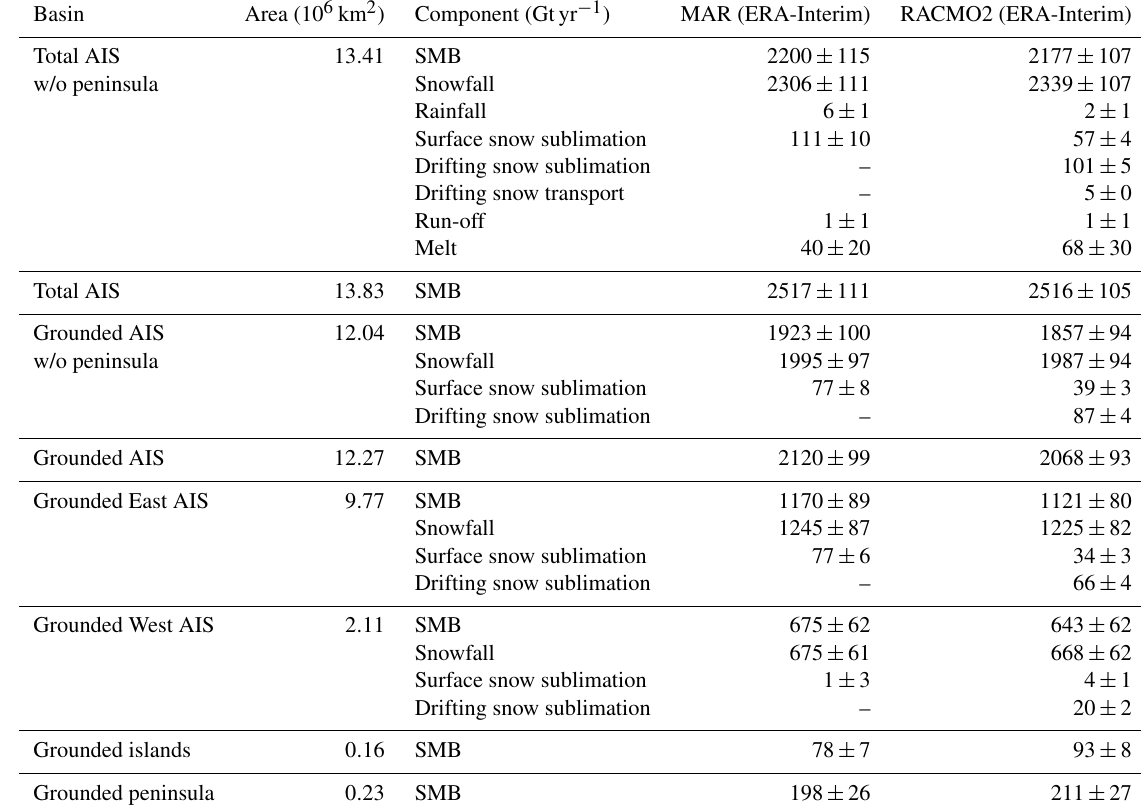
Table 2. Antarctic integrated SMB on average for 1979–2015 ± 1 standard deviation of annual values, in gigatonnes per year. Antarctic ice sheet (AIS) and basin geometry are based on Rignot basins (Shepherd et al., 2018), shown in Fig. 2. RACMO2 is bilinearly interpolated on the MAR grid and the same mask is applied to both models, with area given for this mask. SMB is computed as follows: MAR SMB = snowfall + rainfall − surface snow sublimation − run-off; RACMO2 SMB = snowfall + rainfall − surface snow sublimation − drifting snow sublimation − drifting snow transport −